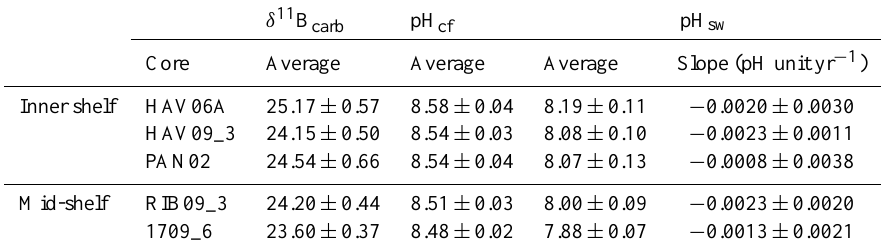
Table 2. Average values and variability (2 SD) for coral δ 11 B carb , pH cf , and reconstructed pH sw calculated over the common period of 1973–2002. The reconstructed pH sw values were estimated using Eq. (2) to correct for the pH offset at the site of calcification. Slopes were obtained from the linear regression of the full length of each core (see Table 1) and are used to indicate the annual rate of change for the reconstructed pH sw records. The uncertainty for the slopes is based on the external reproducibility for the standard.